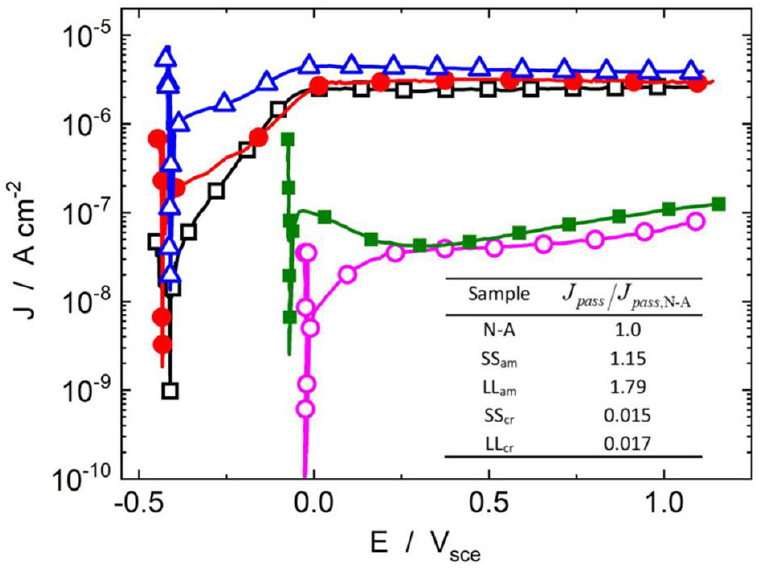
Figure 7. Influence of annealing of anodized Ti on corrosion resistance. Potentiodynamic polari- zation curves of non-anodized Ti implants (N-A: black), anodized Ti implants with amorphous TNTs (SS am : red, LL am : blue), and annealed TNTs with anatase-rutile crystalline phase (SS cr : pink, LL cr : green). Results show that the annealing treatment significantly reduces the passive corrosion current (J pass ) of TNTs, while increasing their corrosion potentials. Inset: passivation current densities [J pass , normalized against the non-anodized sample, J pass,N-A ]. Reproduced with permissions from [103].